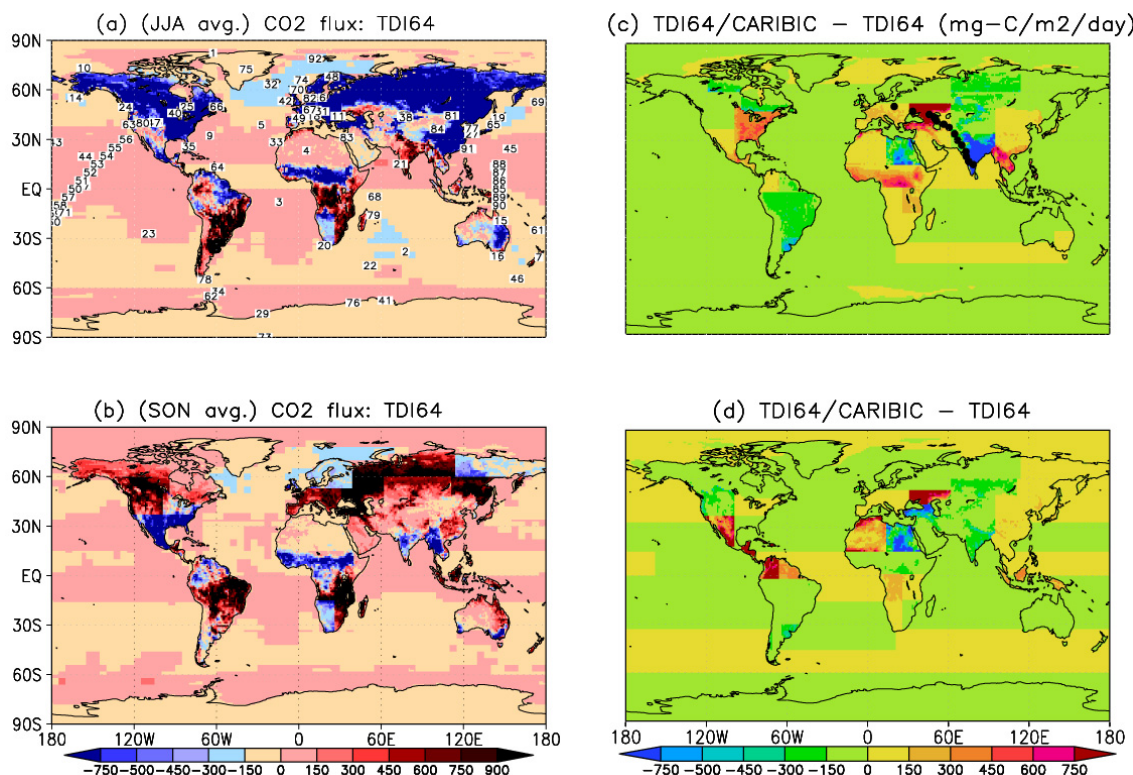
Fig. 2. Three-monthly mean flux distribution maps for June-July-August (JJA; top row) and September-October-November (SON; bottom row) 2008, prepared by distributing 64 region fluxes on to 1 × 1 ◦ latitude-longitude grids for TDI64 inversion using GLOBALVIEW-CO 2 and ACTM forward transport (left column; (a) and (b) , respectively). The right column panels (c and d) show differences in estimated fluxes by including CARIBIC data additionally in inversion (TDI64/CARIBIC). The observation sites used in TDI64 and TDI64/CARIBIC inversions are shown as numbers in panels (a) and (c) , respectively. Note that the CARIBIC observation locations between FRA and MAA are shown as average flight tracks in panel (c) (marked by filled circles for 14 locations as used in